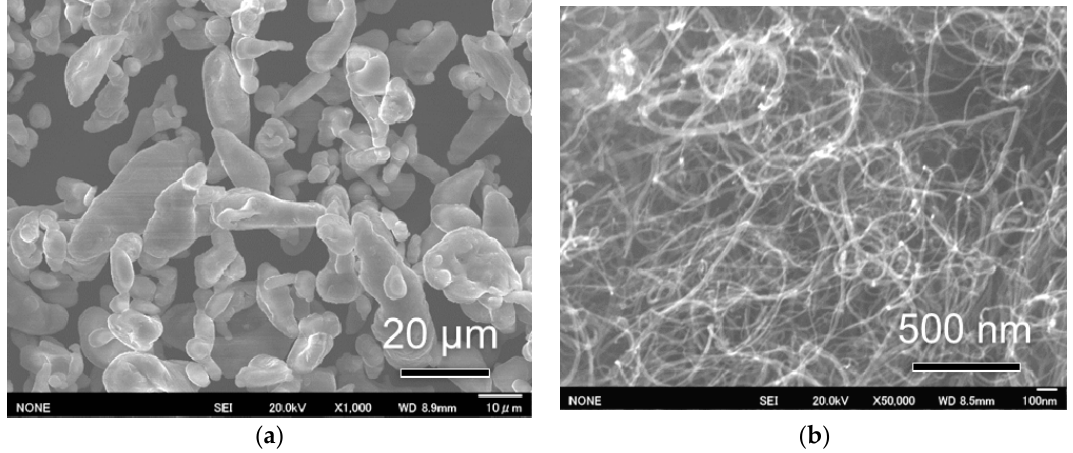
Figure 1. Morphology of starting materials: ( a ) pure Al powder; ( b ) CNT powder.